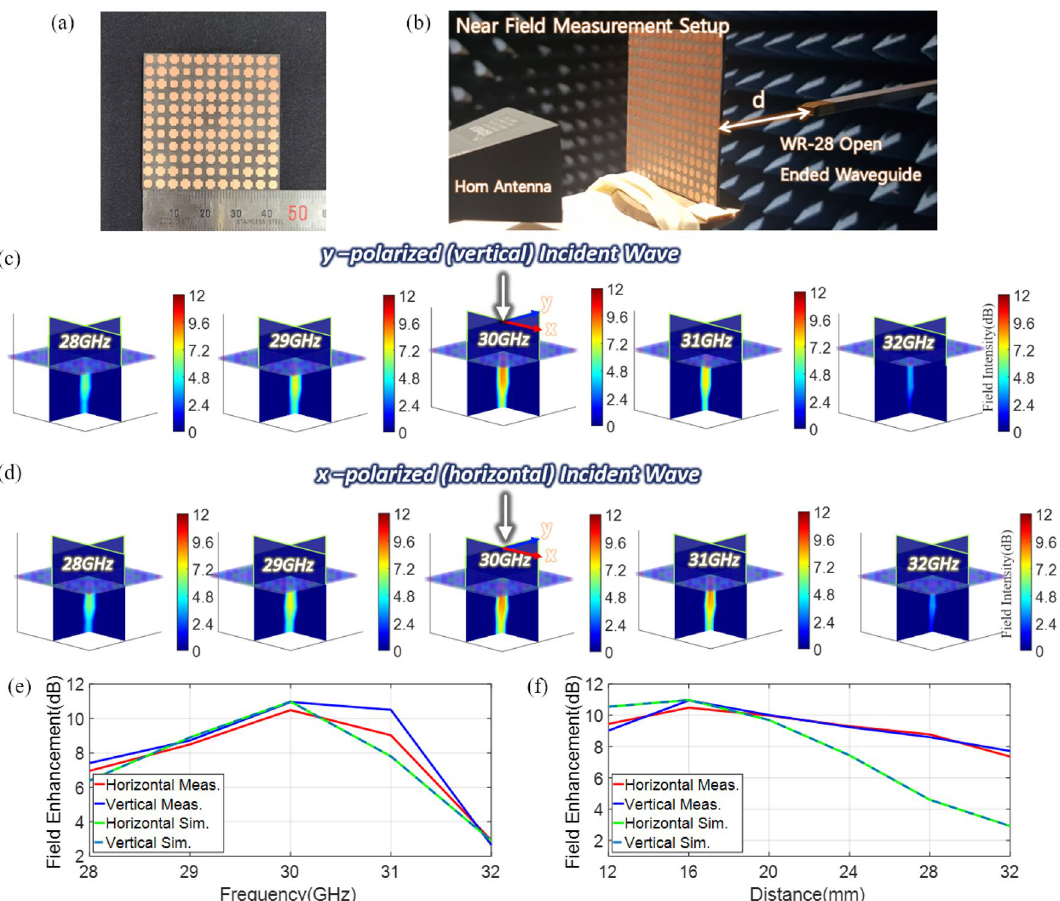
and ( d ) x-polarized (horizontal) incident plane waves at various frequencies. Simulated and measured field enhancement vs. ( e ) frequency when 16 mm apart from the center of the metasurface lens and ( f ) distance from the center of the lens when the frequency is 30